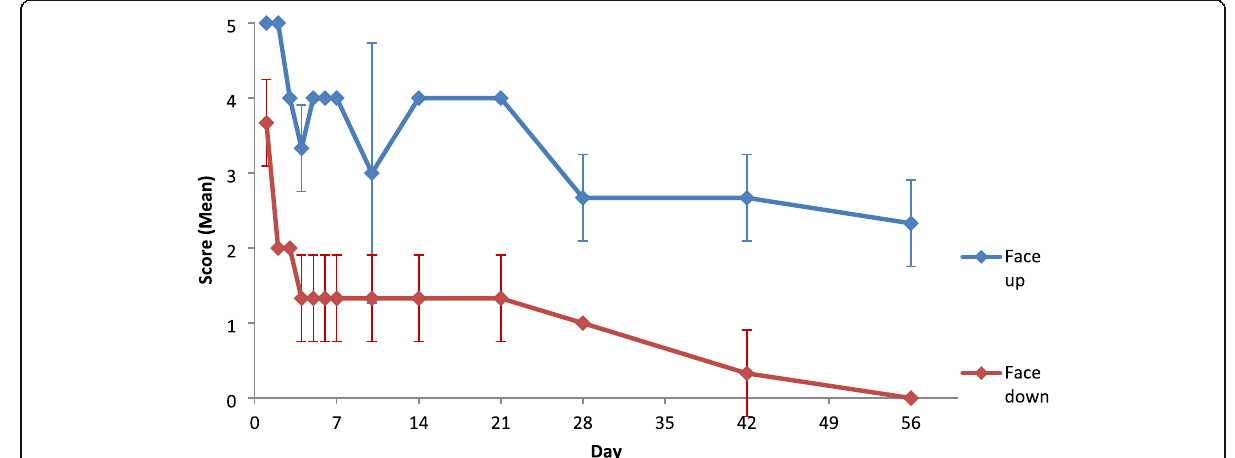
Fig. 17 The comparison of quality of recovered fingermarks in different orientations using Sudan